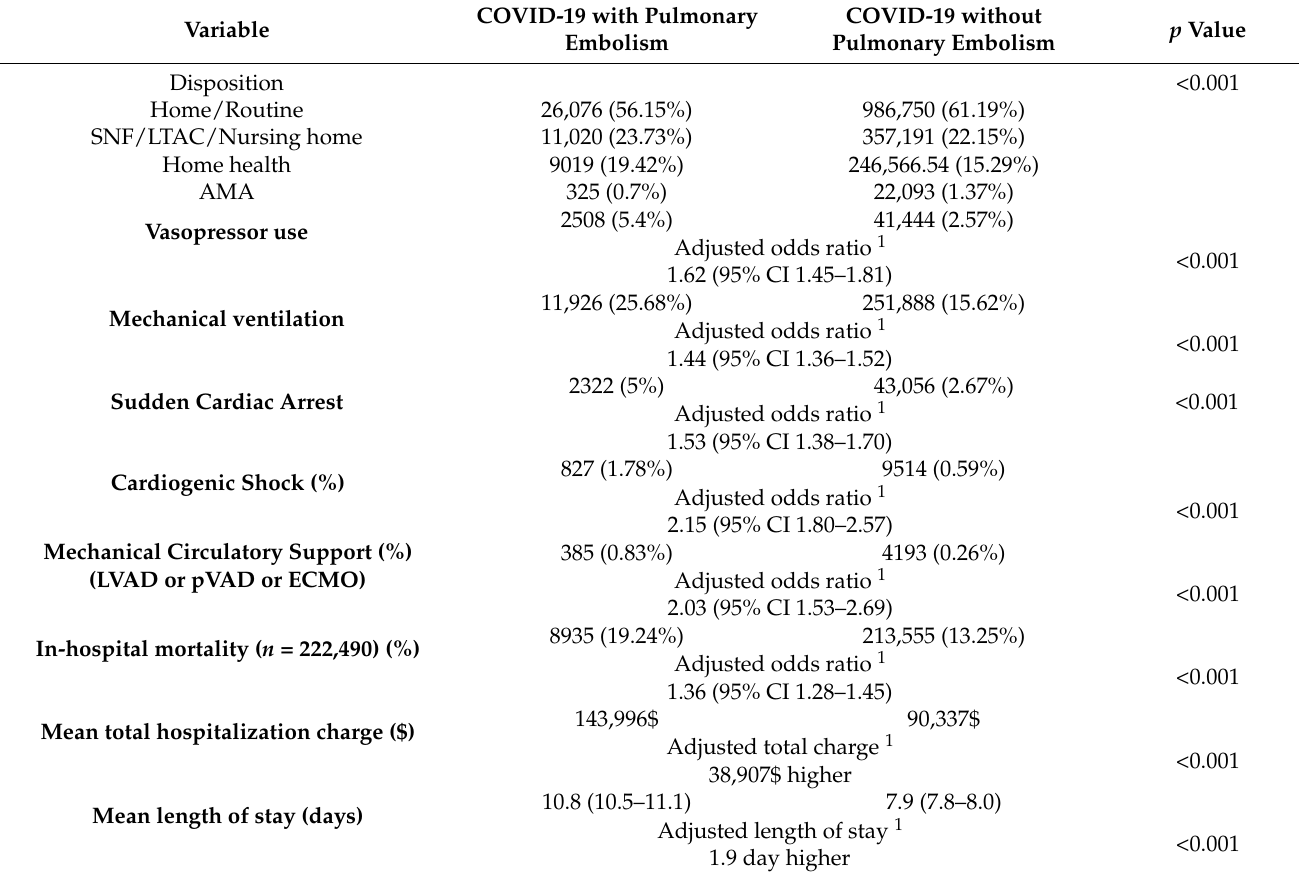
Table 3. In-hospital outcomes of Patients with COVID-19 with and without pulmonary embolism.